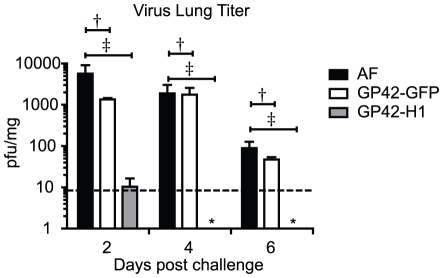
GP42-H1 infection promotes rapid clearance of PR/8 virus challenge.Animals were challenged with 5LD50 of PR/8 virus and the lungs were aseptically removed. The lungs were homogenized and cell free suspensions were collected and assessed for lung virus titers by plaque assay. Data are depicted as the mean pfu per mg of lung homogenate + standard errors of the mean. N = 4. Samples marked by an asterisks (*) did not form plaques and were below the threshold of detection (dashed line). † P>0.05 ‡P<0.01.